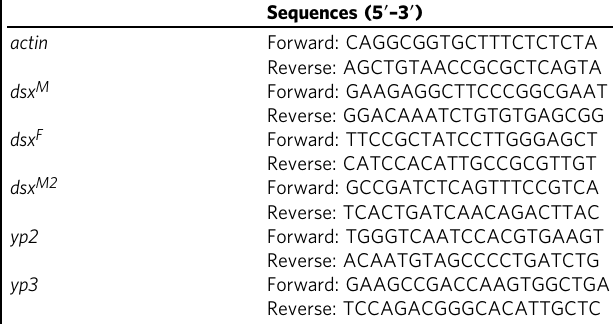
Table 3 Primers used for qPCR